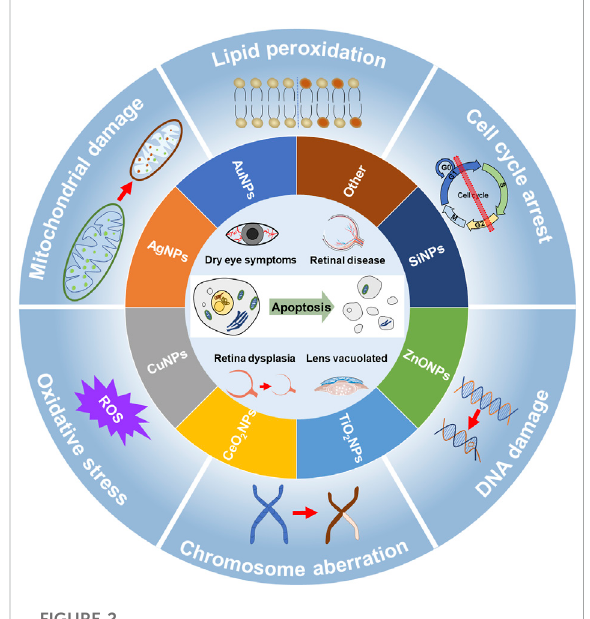
FIGURE 2 Potential ocular toxicity of nanoparticle and its